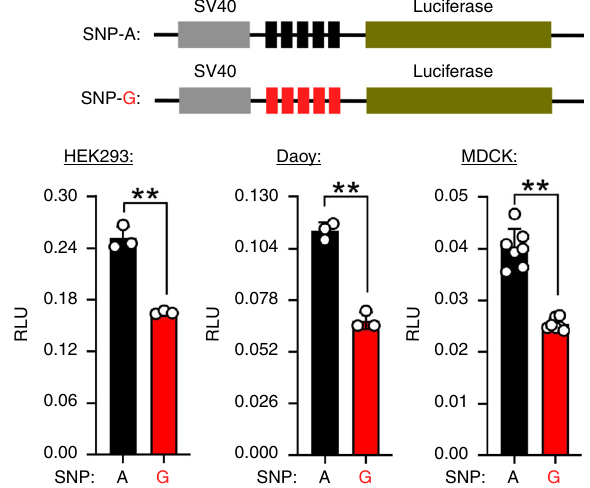
Fig. 5 Functional assay of ARHGEF7. Dual-luciferase reporter experiments (enhancer assay using pGL3-promoter vectors) using two different human cell lines (HEK293, human embryonic kidney and Daoy, human medullablastoma) and one canine cell line (MDCK, Madin-Darby Canine kidney). All experiments were replicated at least three times. Data are expressed by mean ± SEM with the corresponding data points. Graphpad software was used for statistical analysis. Comparisons were performed using two-tails Student ’ s t test. **represents p <